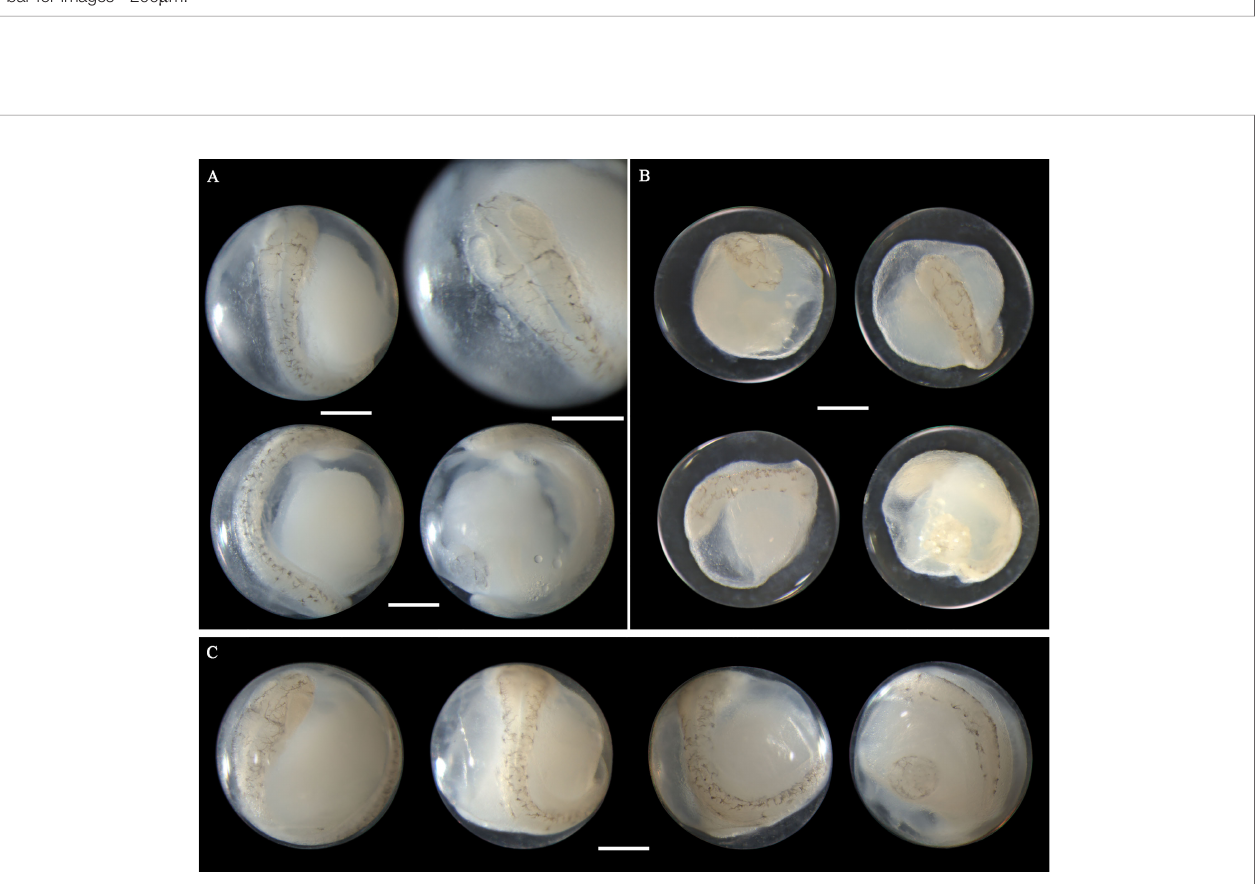
FIGURE 5 | Images of late-stage eggs of Sillago nigrofasciata preserved in (A) ethanol, (B) formalin, and (C) ethanol. Images within each panel represent the same egg photographed from different observation views. Scale bar for images =200 m